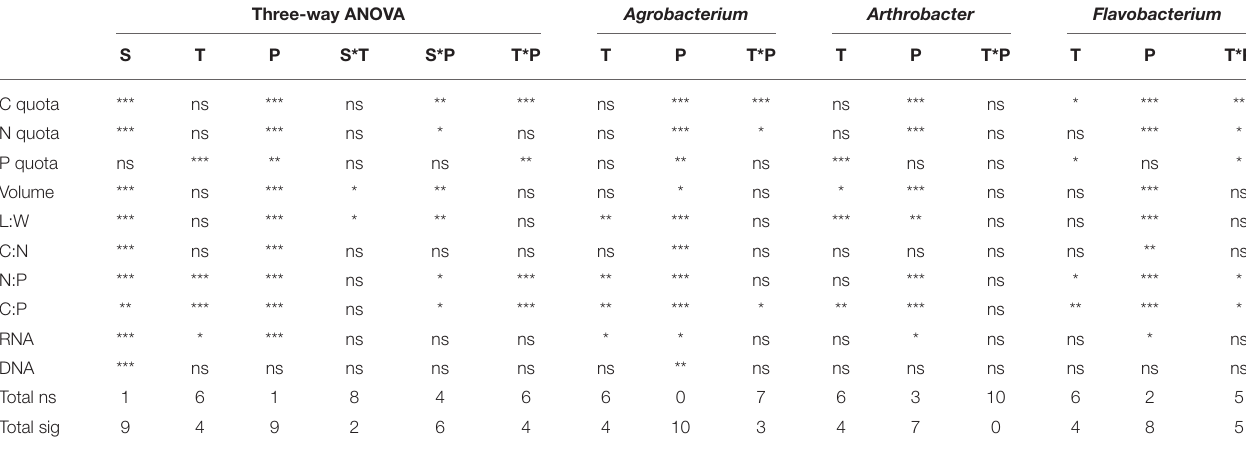
TABLE 1 | Three-way and two-way ANOVAs.